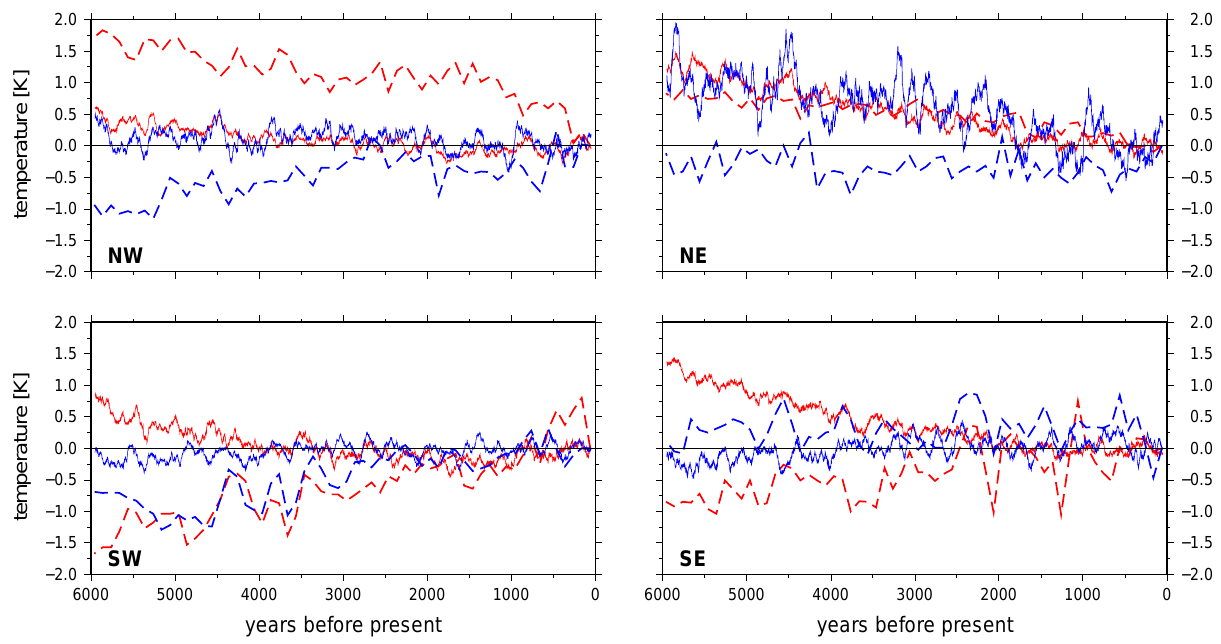
Fig. 6. Comparison of seasonal temperature evolution between model results (solid lines) and reconstructions from pollen data (dashed lines, Davis et al. (2003)) for northwestern (NW), northeastern (NE), southwestern (SW), and southeastern (SE) Europe – summer temperatures (red), winter temperatures (blue). Changes with respect to today’s temperatures.